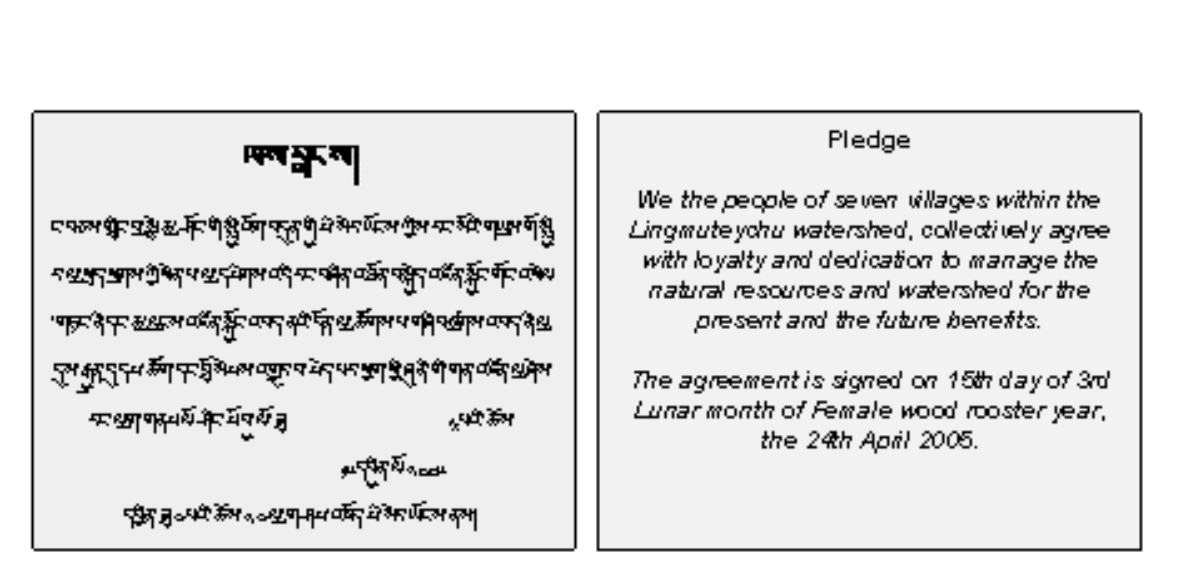
Fig. 13. Pledge to collectively manage the